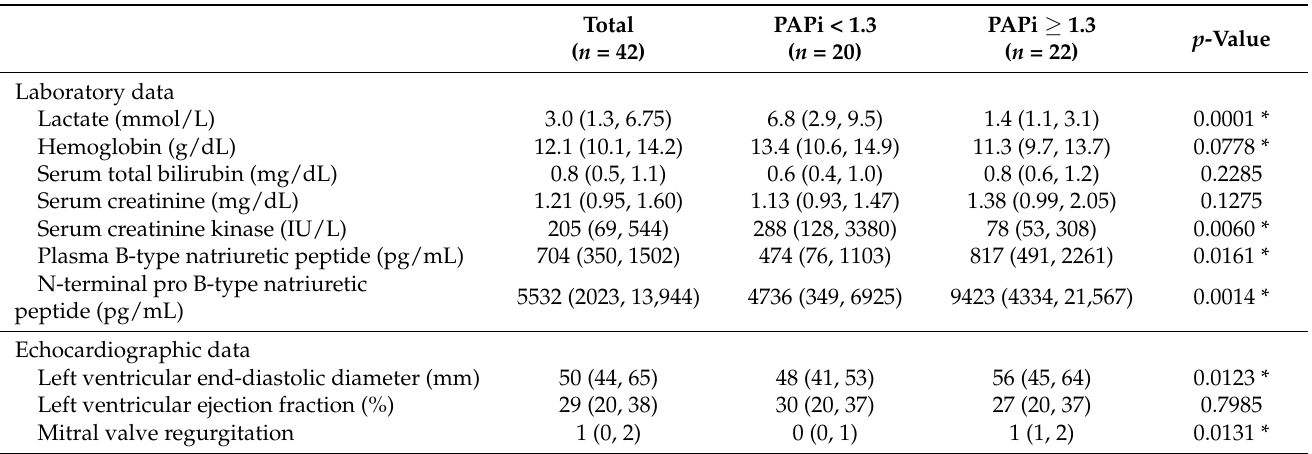
Table 2. Laboratory and echocardiography data on admission.